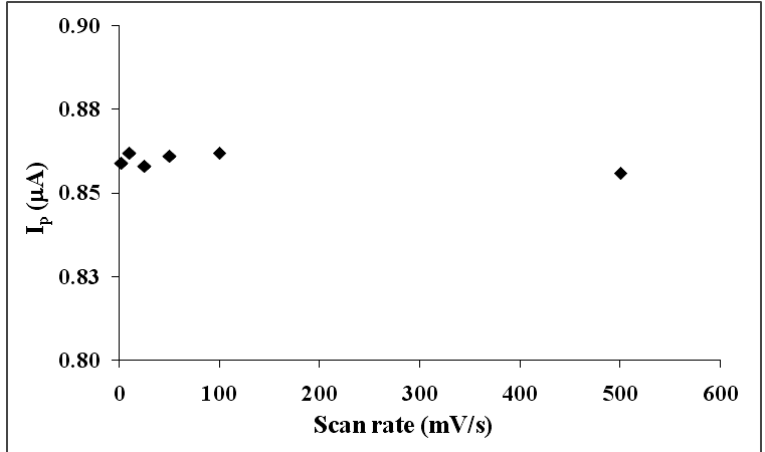
Figure 9. The effect of scan rate using UME-2 (at 2, 10, 25, 50, 100